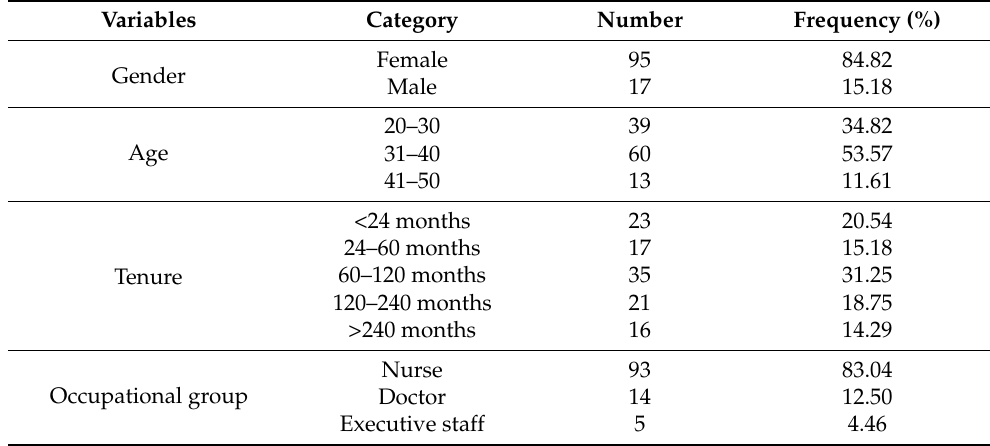
Table 1. Subject characteristics.